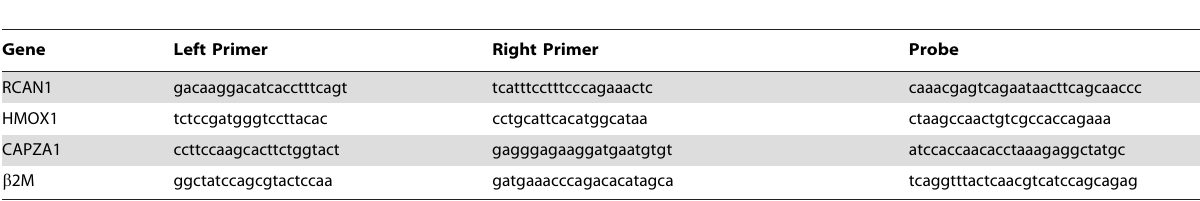
Table 1. Primer and probe sequences for calcineurin regulation, actin dynamics and housekeeping genes.